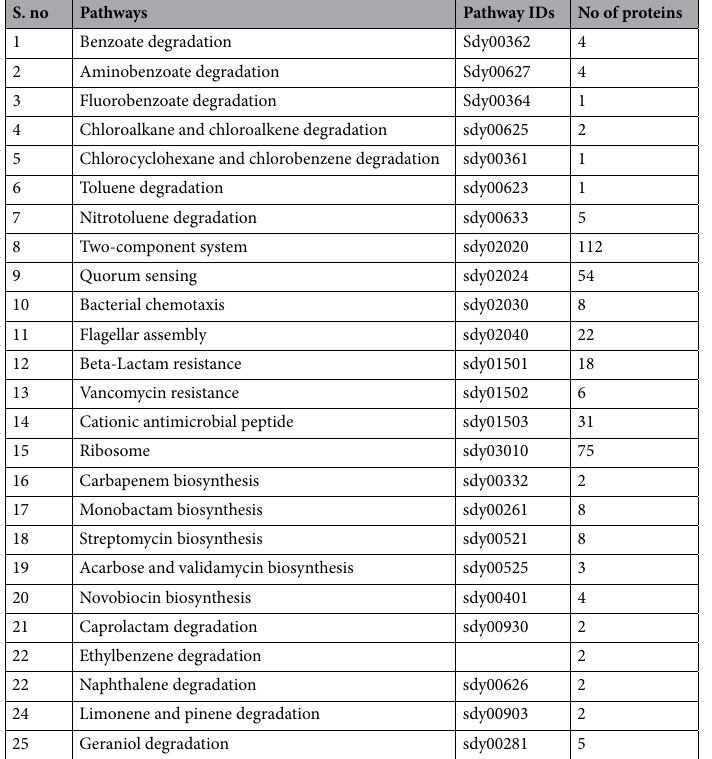
Table 2. Unique metabolic pathways found in Shigella